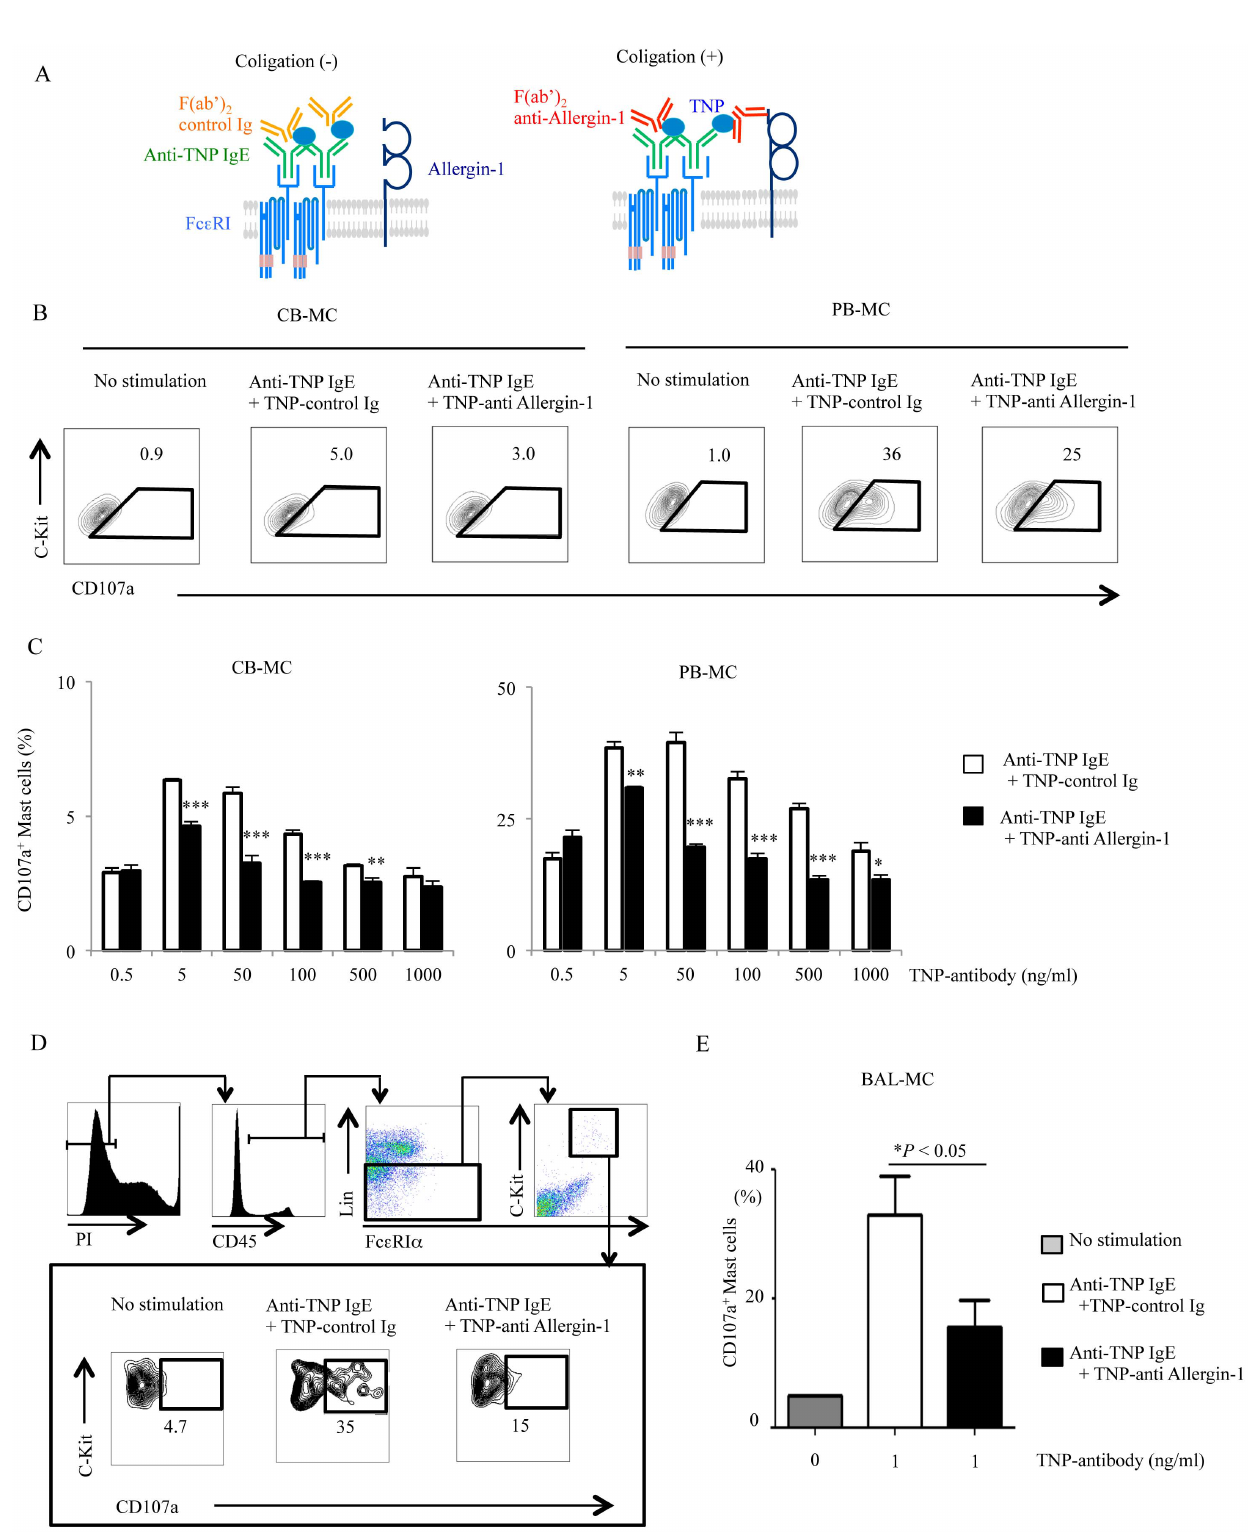
Figure 6. Allergin-1 inhibits IgE-mediated activation of cultured and primary MC. A-C. CB-MC or PB-MC were left unstimulated or stimulated with anti-TNP IgE together with either TNP-conjugated F(ab 9 ) 2 anti-Allergin-1 (specific to Allergin-1S1) or control Ig, as described in the Methods, and analyzed for the expression of CD107a. D, E. BALF cells were left unstimulated or stimulated, as described in A, and stained with mAbs indicated, as described in the Methods, for MC gating. p , 0.05; *, p , 0.01; **, p , 0.001; ***.